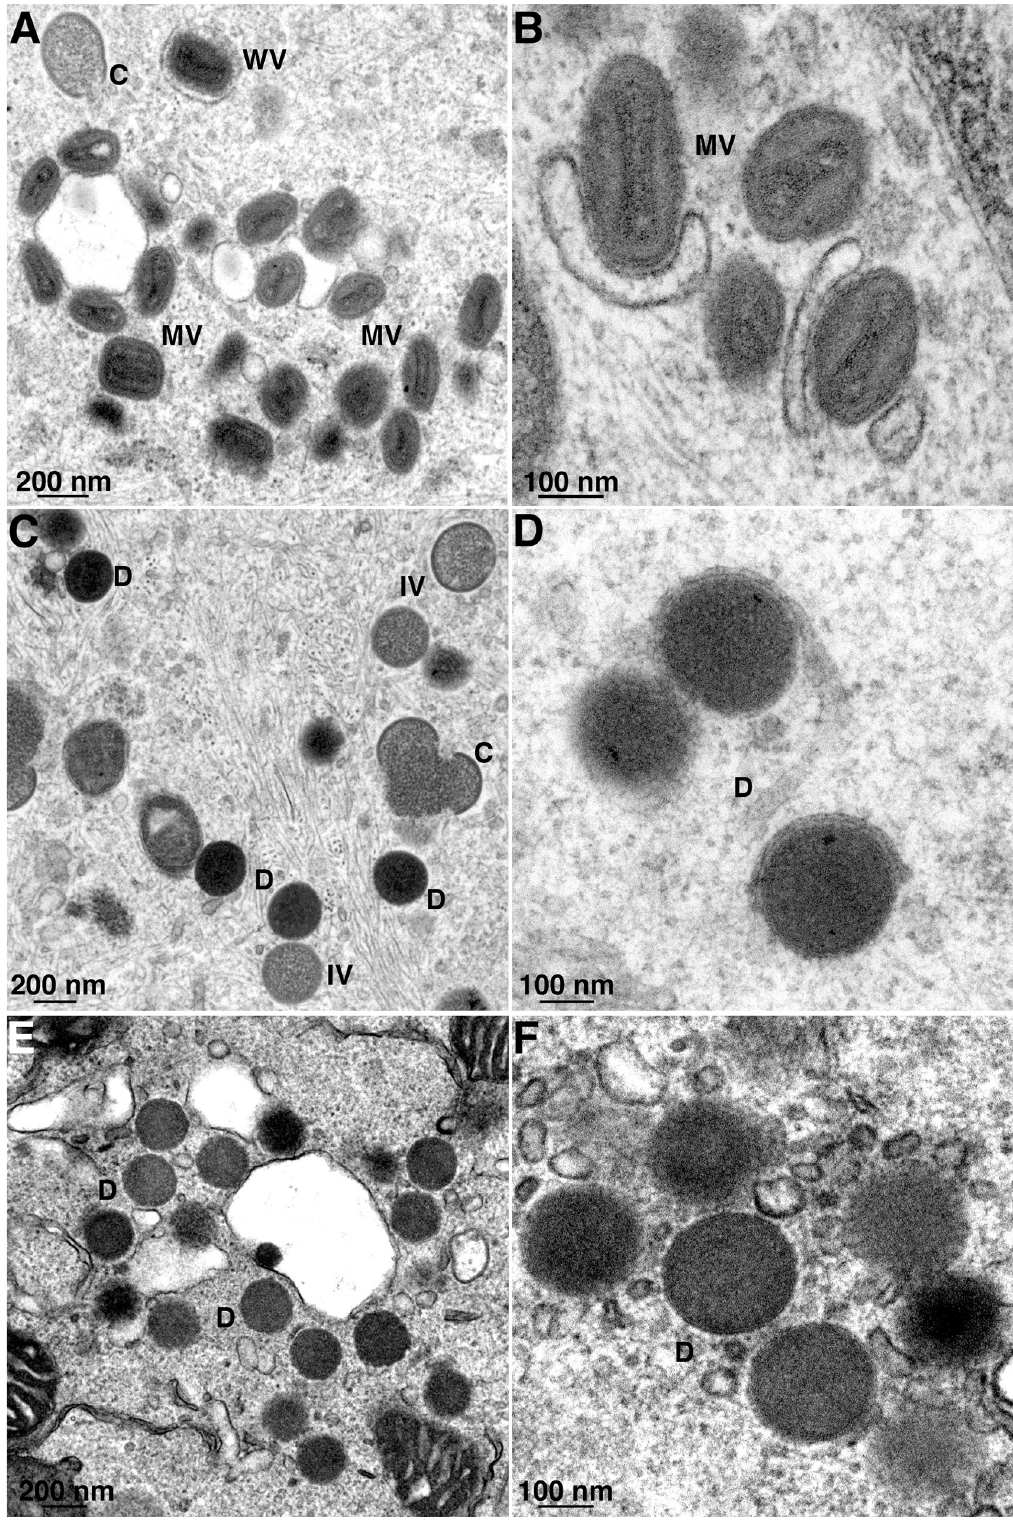
Fig 1. Morphogenesis defects of WR Δ SPI-1 and MVA. A549 cells infected with VACV WR ( A, B ), WR Δ SPI-1 ( C, D ) or MVA ( E, F ) were analyzed by transmission electron microscopy. Abbreviations: MV, mature virion; WV, wrapped virion; C, crescent; IV, immature virion; D, dense virion. Magnification shown below each panel. https://doi.org/10.1371/journal.ppat.1007710.g001 PLOS Pathogens| https://doi.org/10.1371/journal.ppat.1007710 May 30,